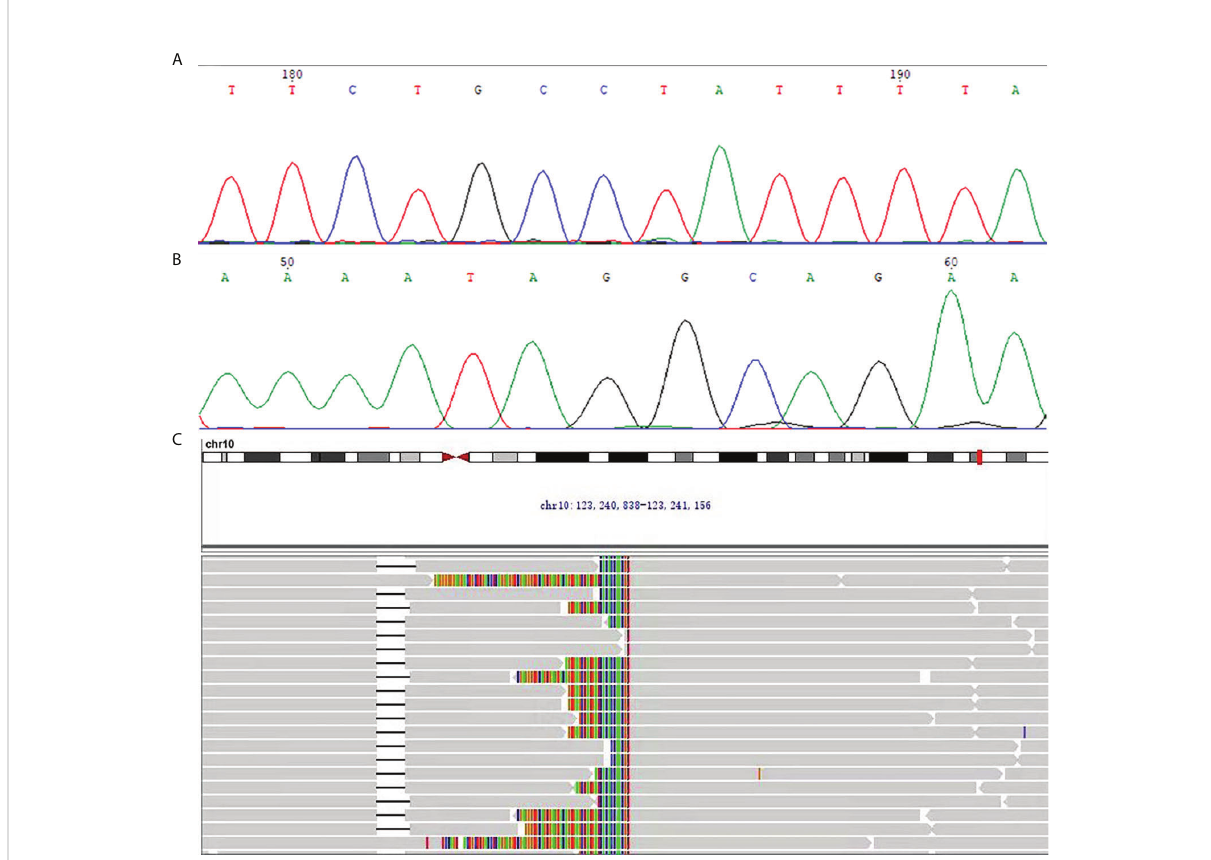
FIGURE 3 (A, B) The representative chromatogram of Sanger sequencing. (A) The forward sequencing result at exon 9 of c-KIT for the GIST in this case. (B) The reverse sequencing result at exon 9 of c-KIT for the GIST in this case. (C) NGS revealed the presence of the FGFR2-KIAA1217 gene fusion (3.88% abundance in